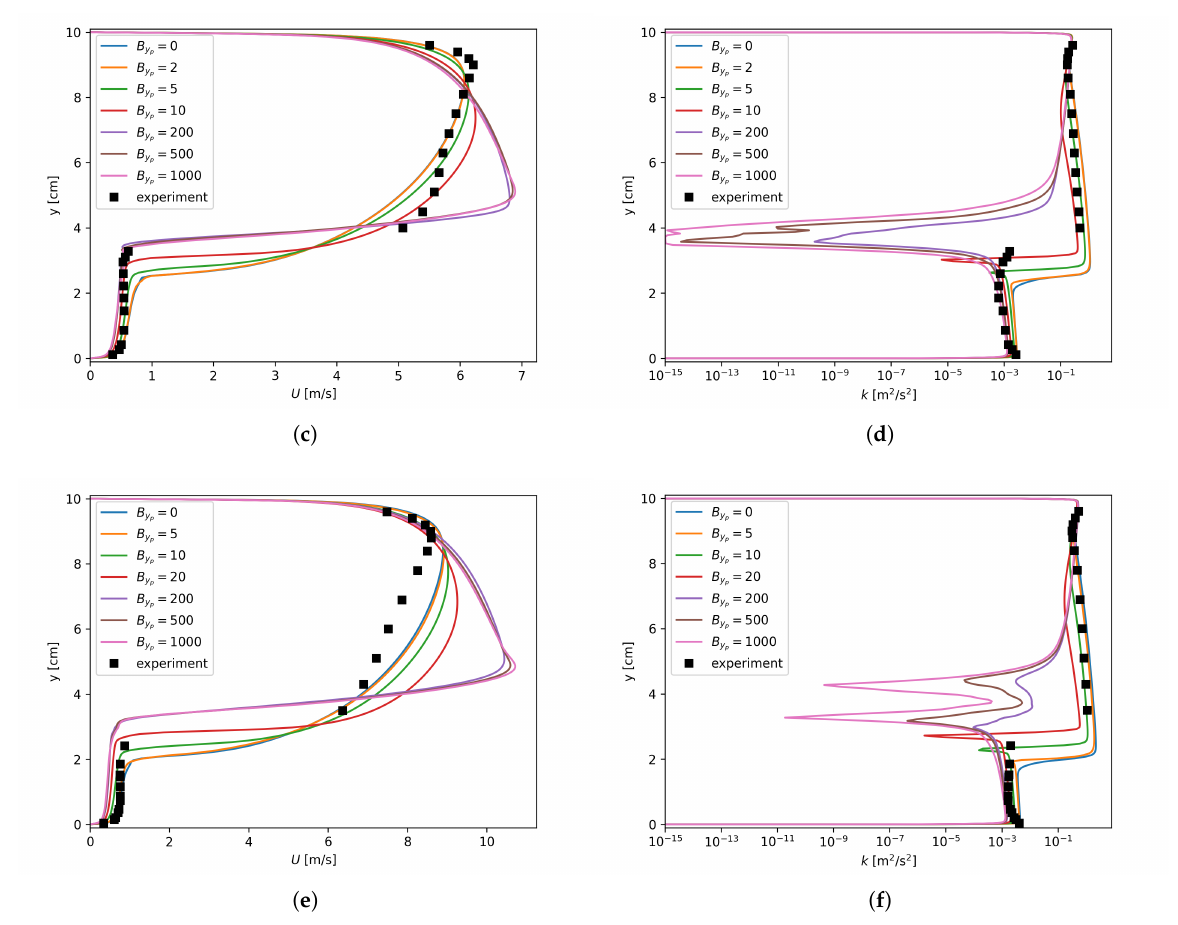
Figure 9. Axial velocity and turbulent kinetic energy dependency on B y ( b ) Run 250, k ; ( c ) Run 400, U ; ( d ) Run 400, k ; ( e ) Run 600, U ; ( f ) Run 600, k